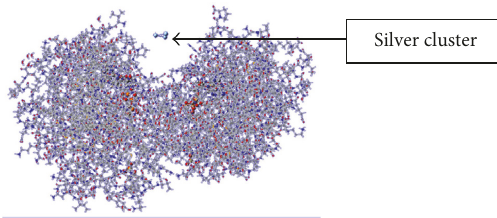
Figure 16: Interaction between the crystal structure of FGF Re- ceptor 2 Tyrosine Kinase Domain Harboring the D650V Activating Mutation and the 3-atom silver cluster.